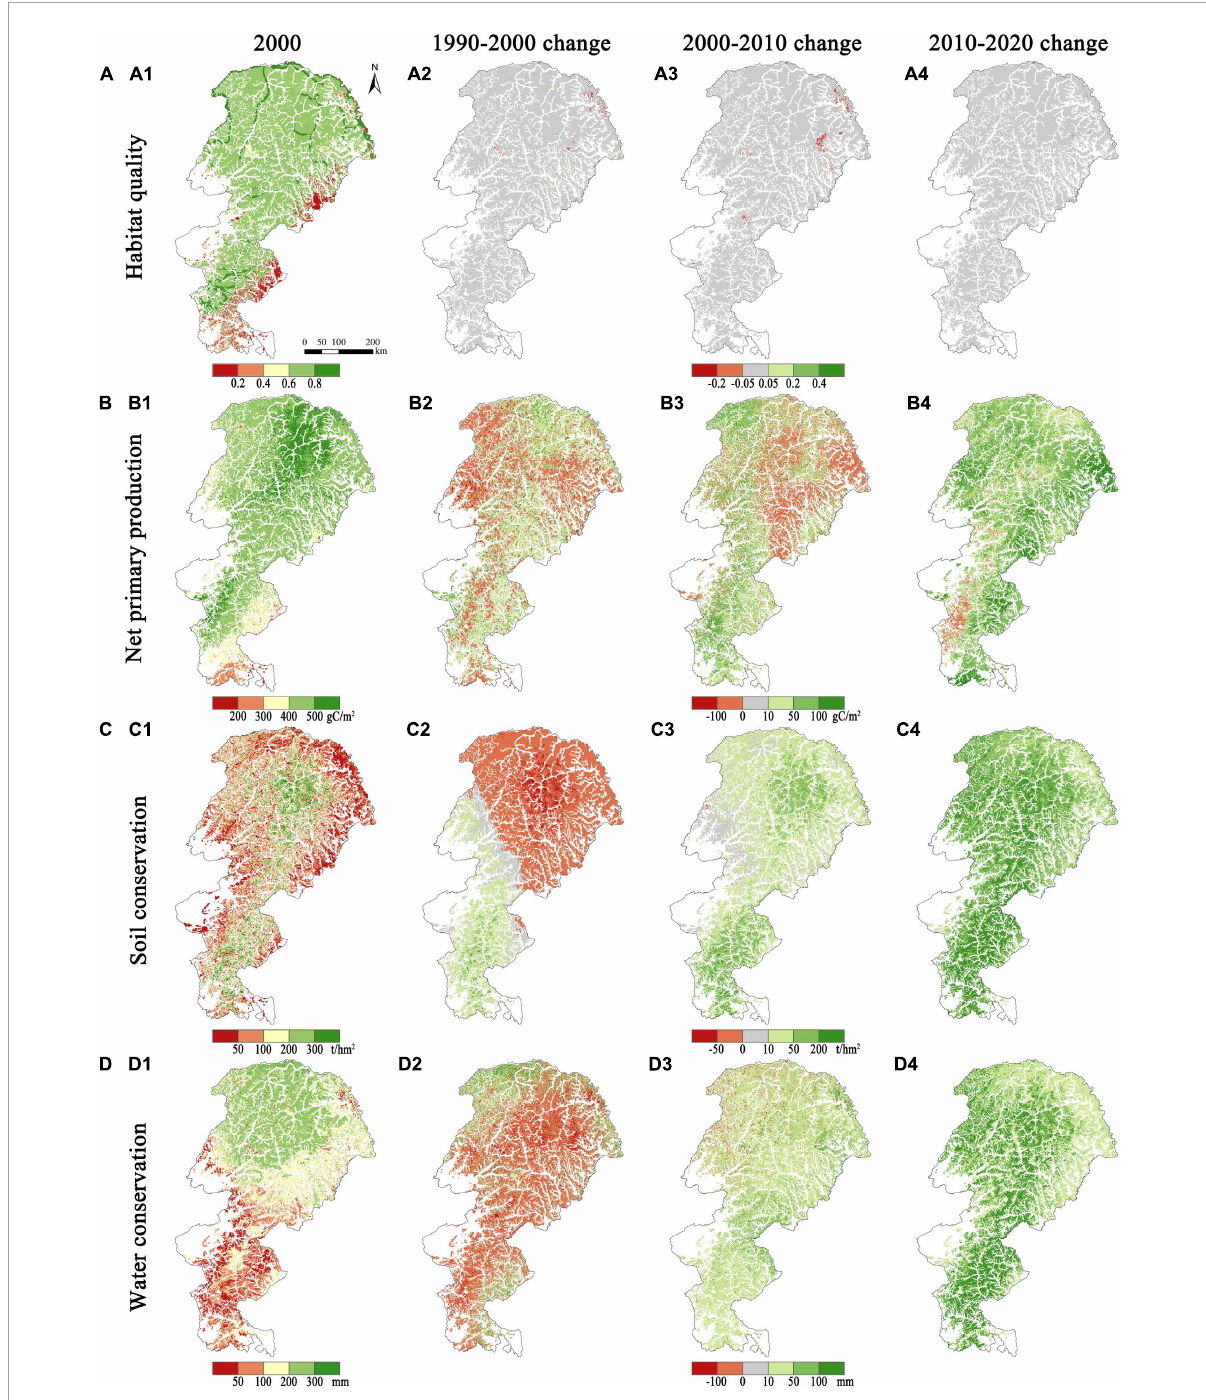
FIGURE3 Changes of forest ecosystem services in the Greater Khingan Mountains from 1990 to 2020. (A) Habitat quality, (B) net primary production, (C) soil conservation, and (D) water conservation.